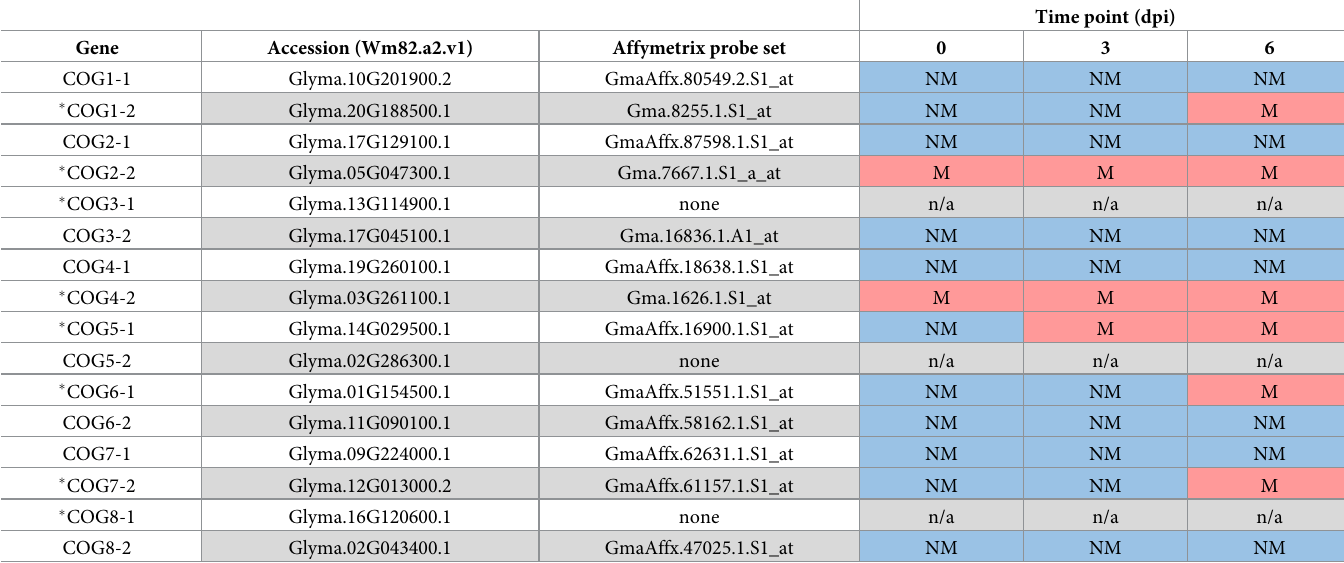
Table 1. G . max COG syncytium gene expression